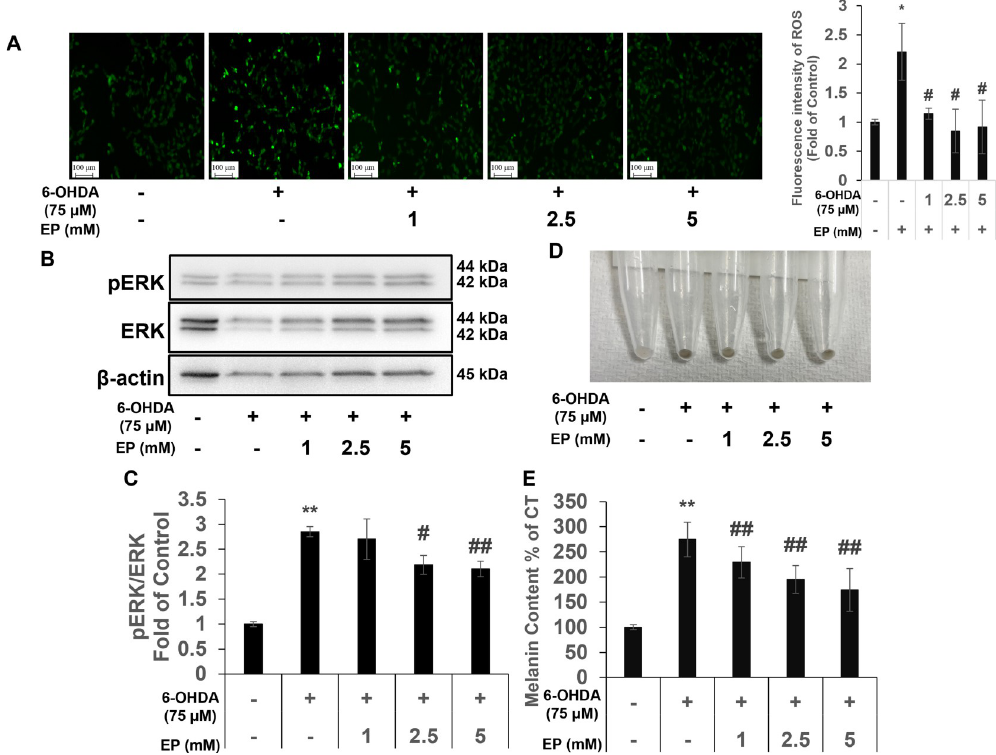
Fig 3. Effects of ethyl pyruvate (EP) on 6-hydroxydopamine (6-OHDA)-induced intracellular reactive oxygen species (ROS) and neuromelanin contents. (a) Reactive oxygen species (ROS) determined from fluorescence microscopy images. Scale bars: 100 μ m. Representative western blots (b) of pERK and extracellular signal-regulated kinase (ERK) quantified (c) using ImageJ. (d) Intracellular neuromelanin deposition. (e) Neuromelanin content and normalized the controls. Results are expressed as means ± standard deviation (N � 3) � P < 0.01 vs . control; † P < 0.05 and ‡ P < 0.01 vs . 6-OHDA.